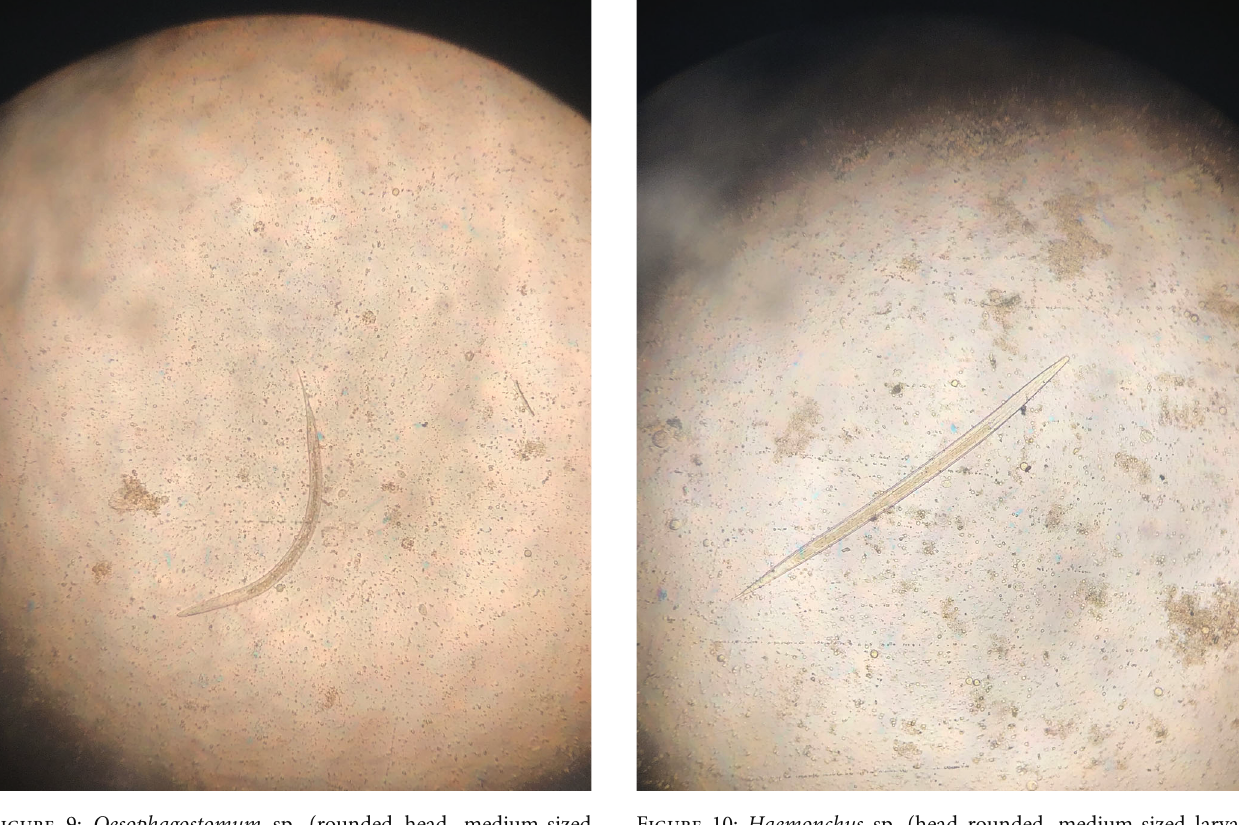
Figure 10: Haemonchus sp. (head rounded, medium-sized larva with medium length, and kinked sheath tail). Third-stage larvae.